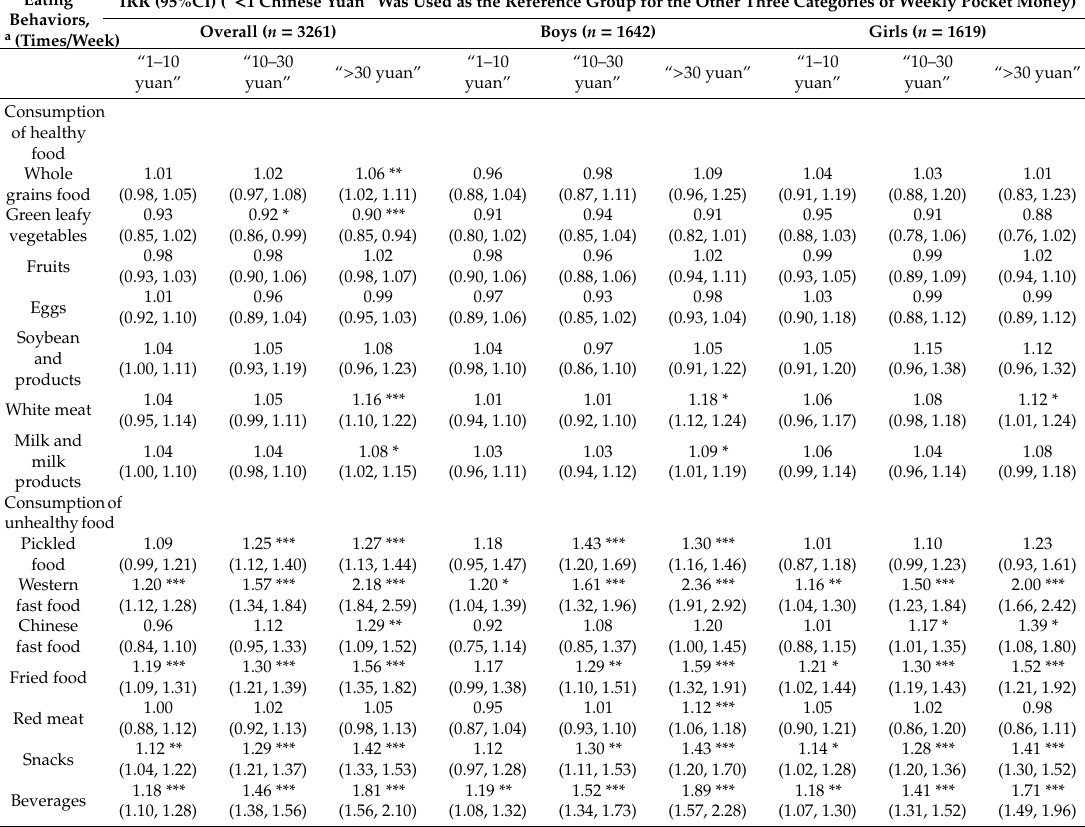
Table 3. Longitudinal associations (IRR and 95% CI) between children’s pocket money and their eating behaviors: The Childhood Obesity Study in China Mega-Cities, 2015–2017. Eating (95%CI) (“ < 1 Chinese Yuan” Was Used as the Reference Group for the Other Three Categories of Weekly Pocket Behaviors,